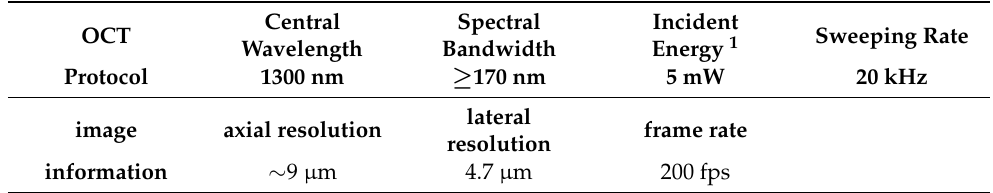
Table 1. Performance indicators of